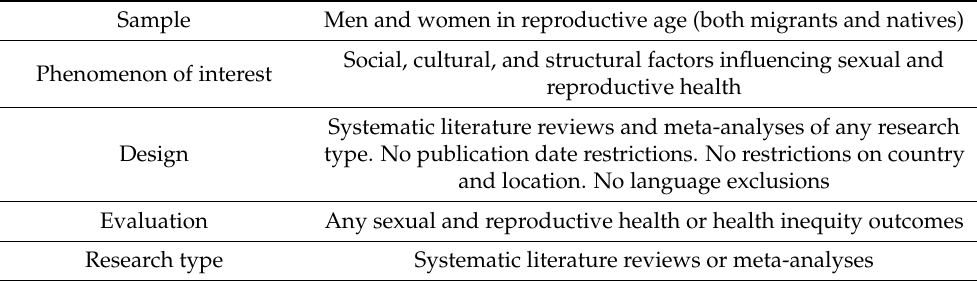
Table 1. Scope of the umbrella systematic literature review (research question, objectives, and search strategy). Sample Men and women in reproductive age (both migrants and natives) Social, cultural, and structural factors influencing sexual and Phenomenon of interest reproductive health Systematic literature reviews and meta-analyses of any Design